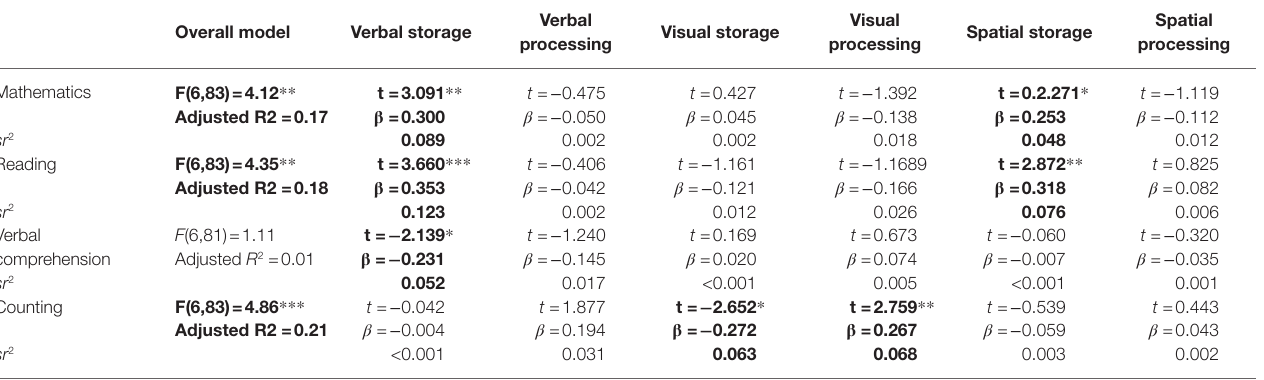
TABLE 6 | Multiple regressions showing combined predictors of performance on academic measures. Overall model Verbal storage